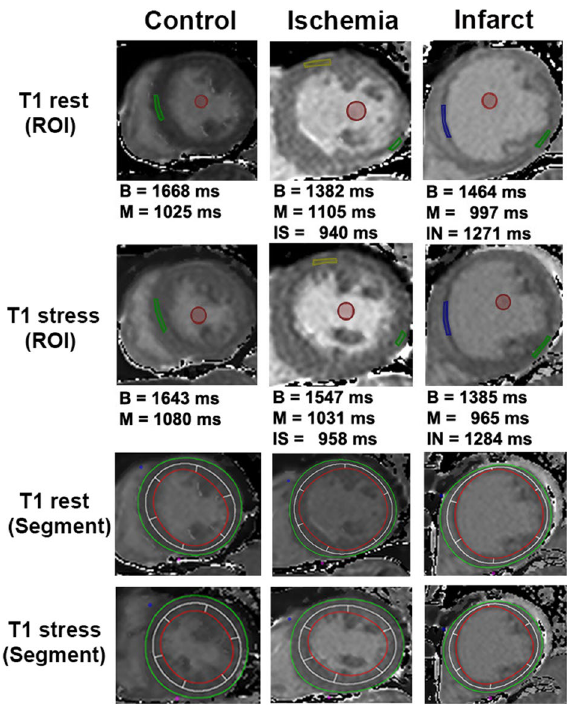
Figure 3. Definition of region of interest (1st and 2nd panel) and subendocardial contour (3rd and 4th panel) on myocardial T1 maps at rest and stress for group